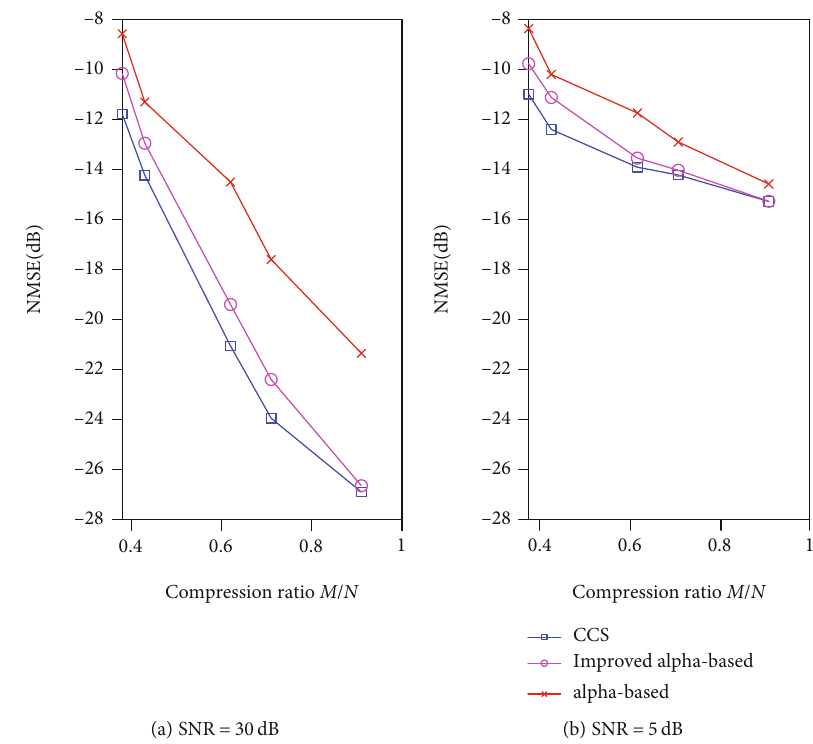
Figure 7: Normalized mean square spectrum estimation error NMSE vs. compression ratio ( M / N ) for the three methods using the Fourier basis: the alpha-based, the improved alpha-based, and the Blackman-Tukey estimation through LS-CCS.